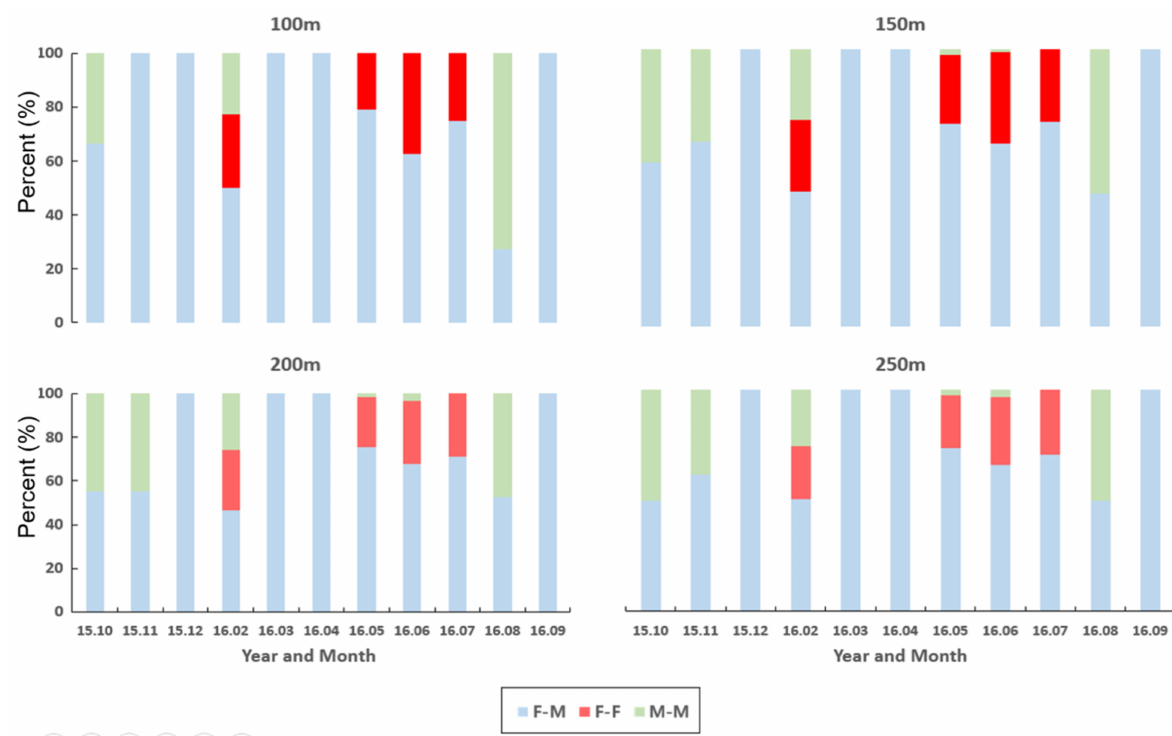
Figure 8. Relative frequencies of co-occurring individuals for the same and different sexes across distances from 100 m to 250 m in the Macdo wetland during the survey period (October 2015–September 2016).